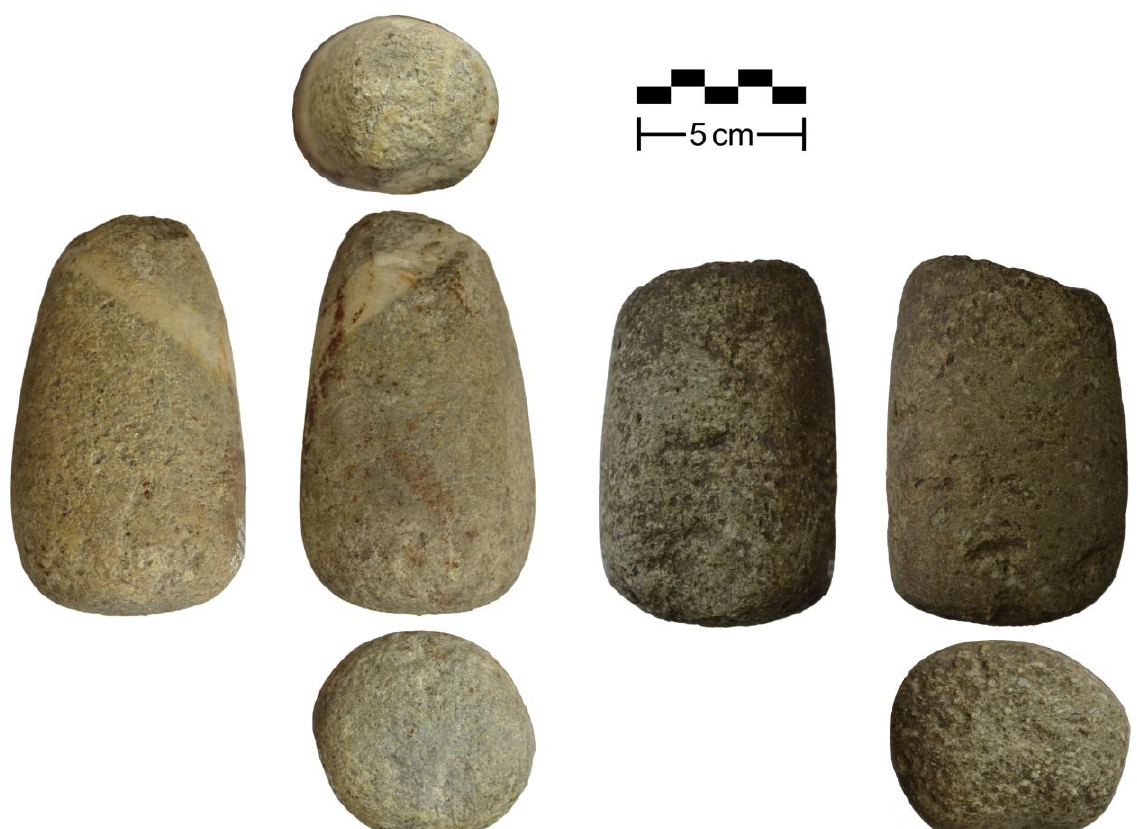
Figure 6. Examples of possible grinding hand stones from Măgura ‘Buduiasca’. Grinding and crushing marks are visible on the lower surface.